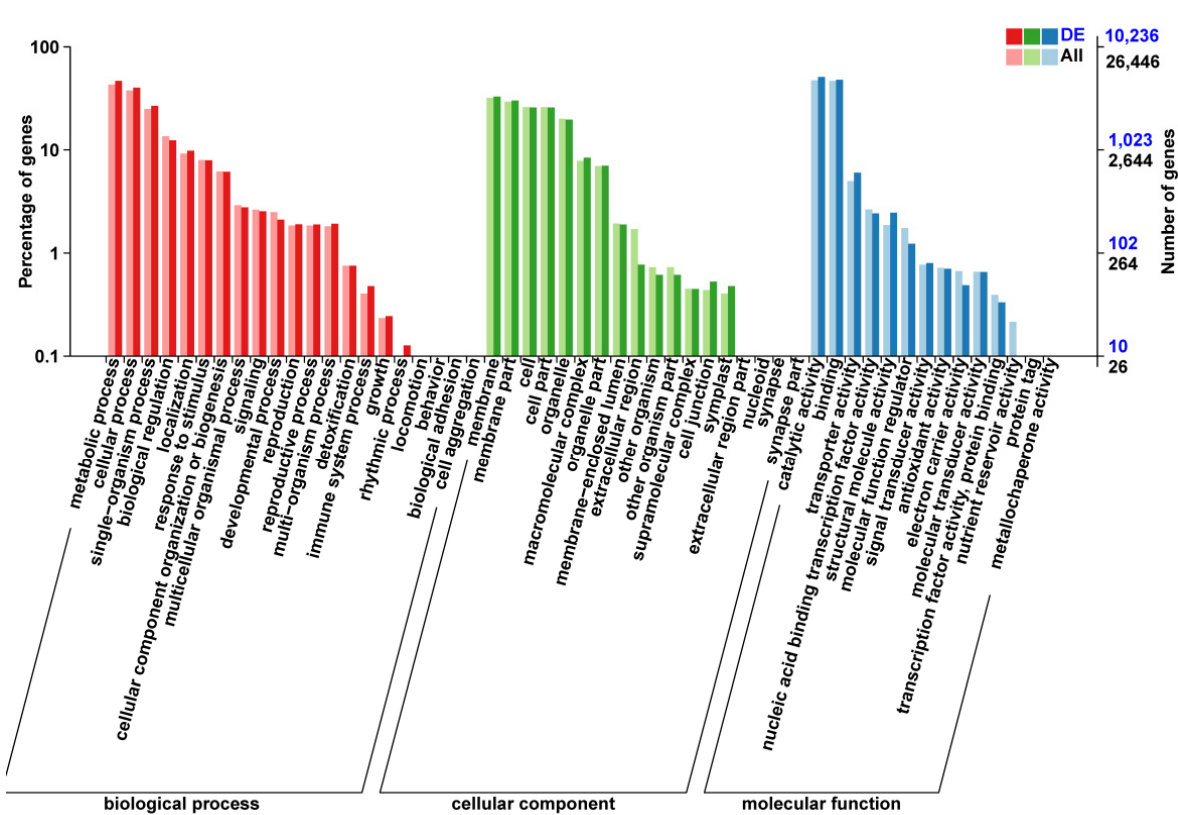
Figure 4. Volcano map of DEGs. The abscissa is the change in gene expression (log 2 FC), and the ordinate is the significance level of differentially expressed genes ( − log 10 FDR). The expression of green genes was down-regulated, the expression of red genes was up-regulated, and the expres- sion of black genes was not significantly different.